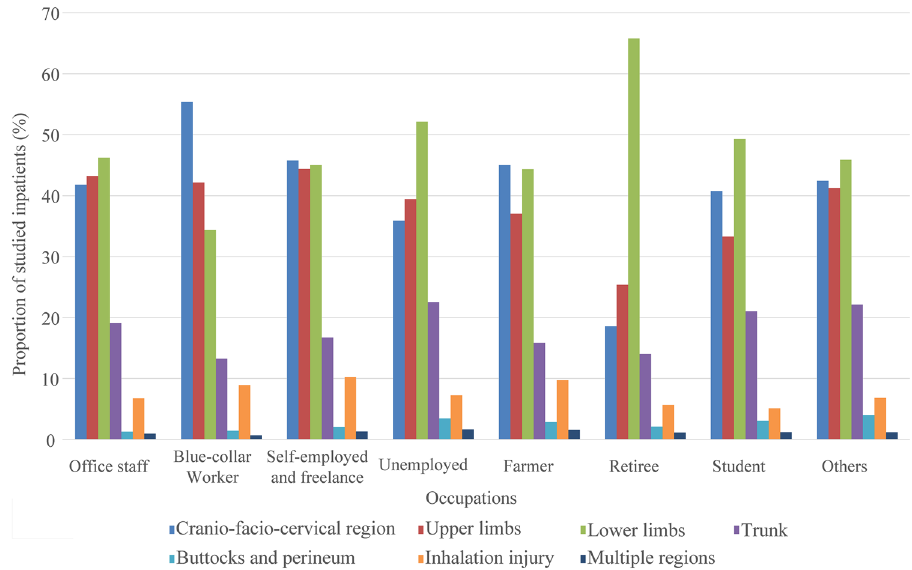
Figure 5. Proportions of different anatomic site burned inpatients in different occupations. The X-axis represents the occupations. The left Y-axis corresponding to the bars represents the proportion of each burn site group in burn